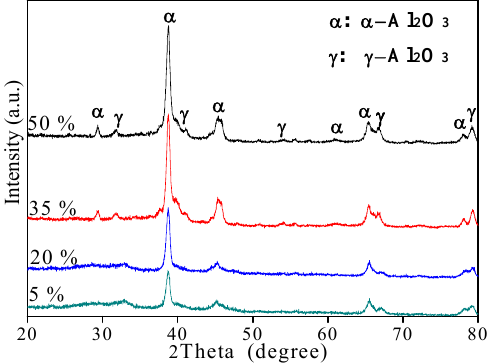
Figure 5. The X-ray diffraction (XRD) patterns of CPED coatings.